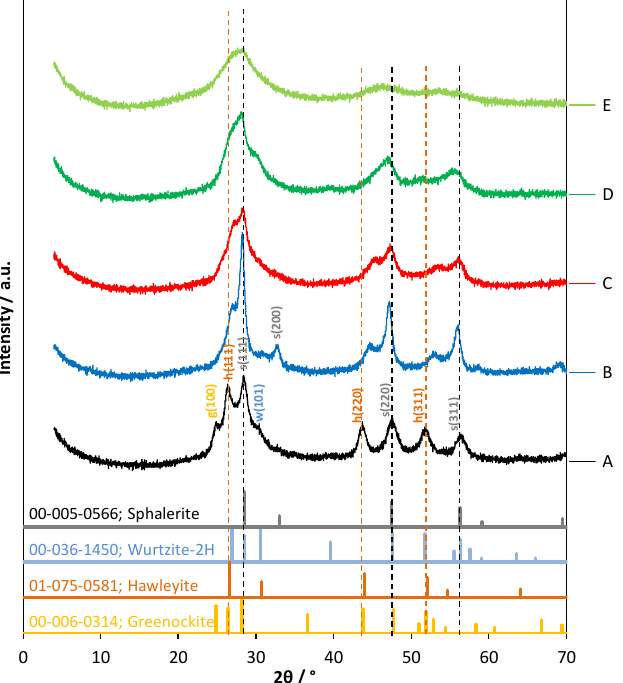
Figure 4. XRD patterns of photocatalysts: A: mixture of ZnS and CdS (in 3:1 molar ratio) synthesized and hydrothermally treated in the same way as other catalysts, B: Cat-0N, C: Cat-1N, D: Cat-2N, and E: Cat-2N-0H. The vertical lines designate the characteristic peaks of cubic sphalerite (gray) and hawleyite (red).